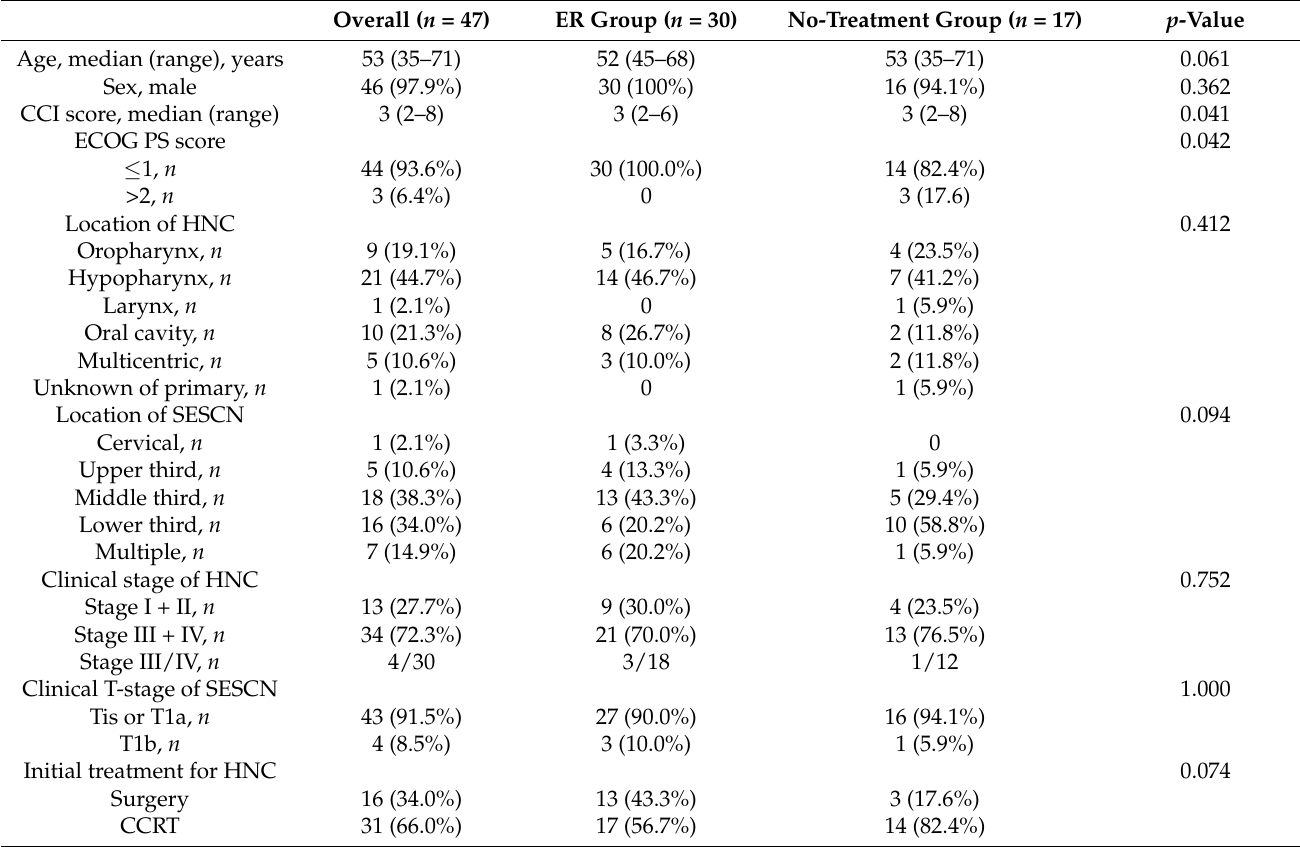
Table 1. Patient and tumor